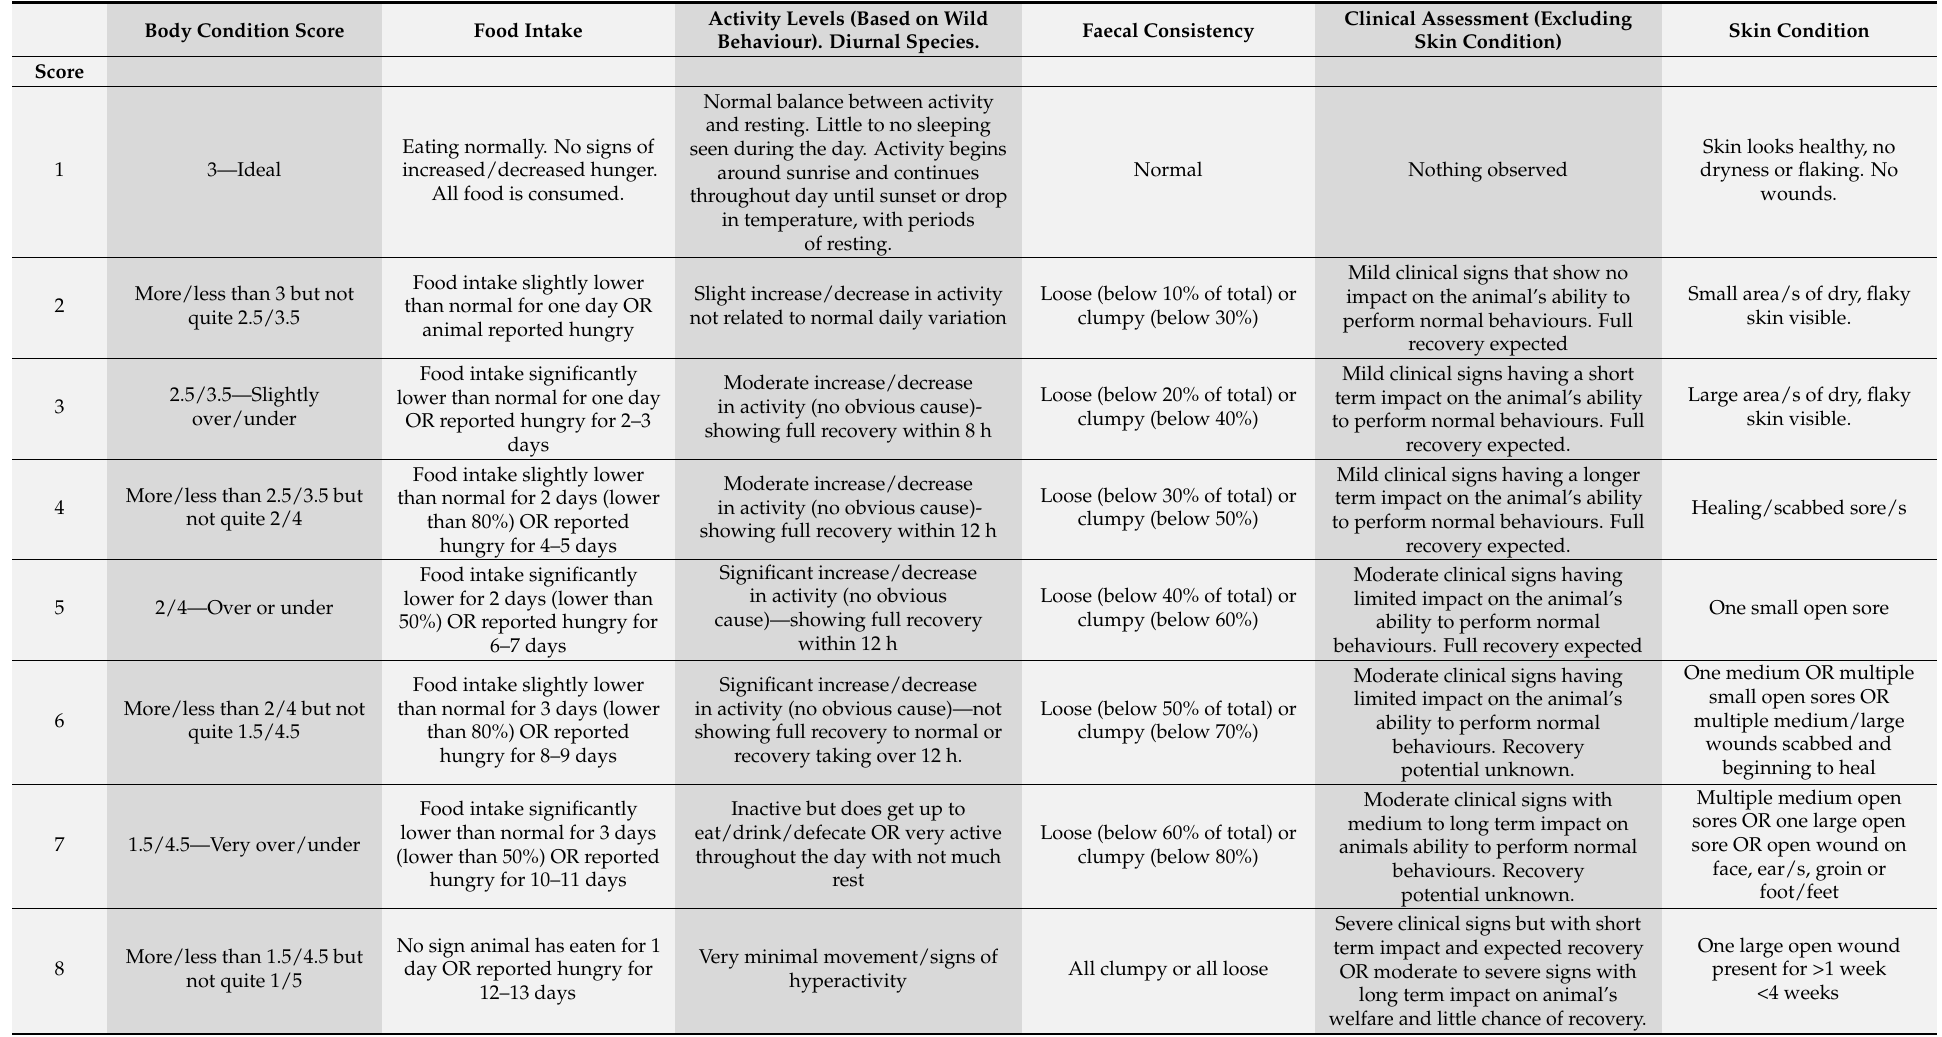
Table 1. Factors scored within the physical